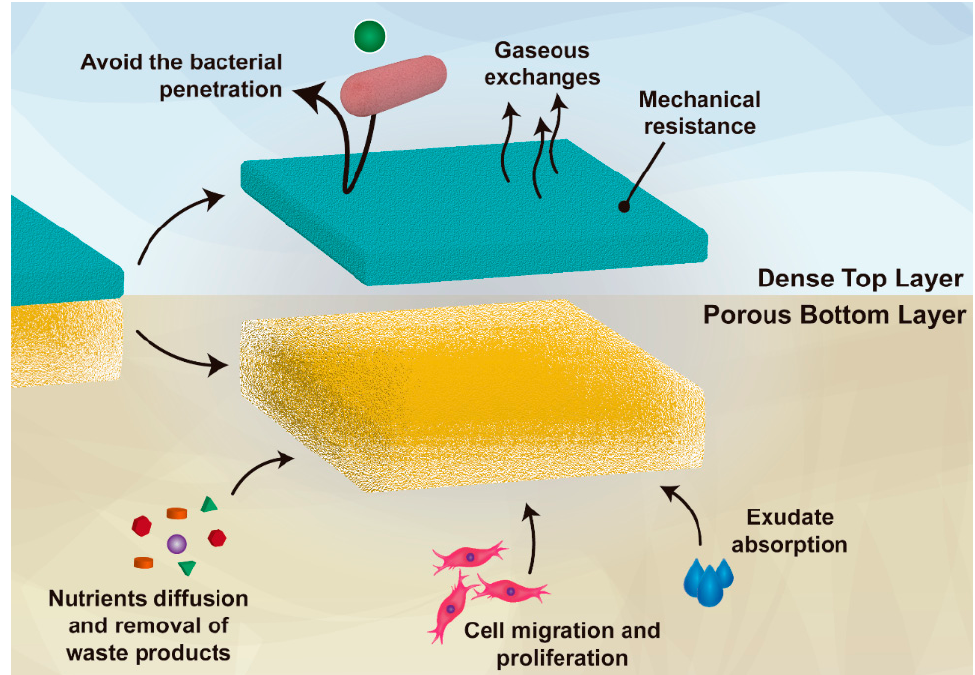
Figure 1. Illustration of the main functions of both layers (top and bottom) of an asymmetric mem- brane.